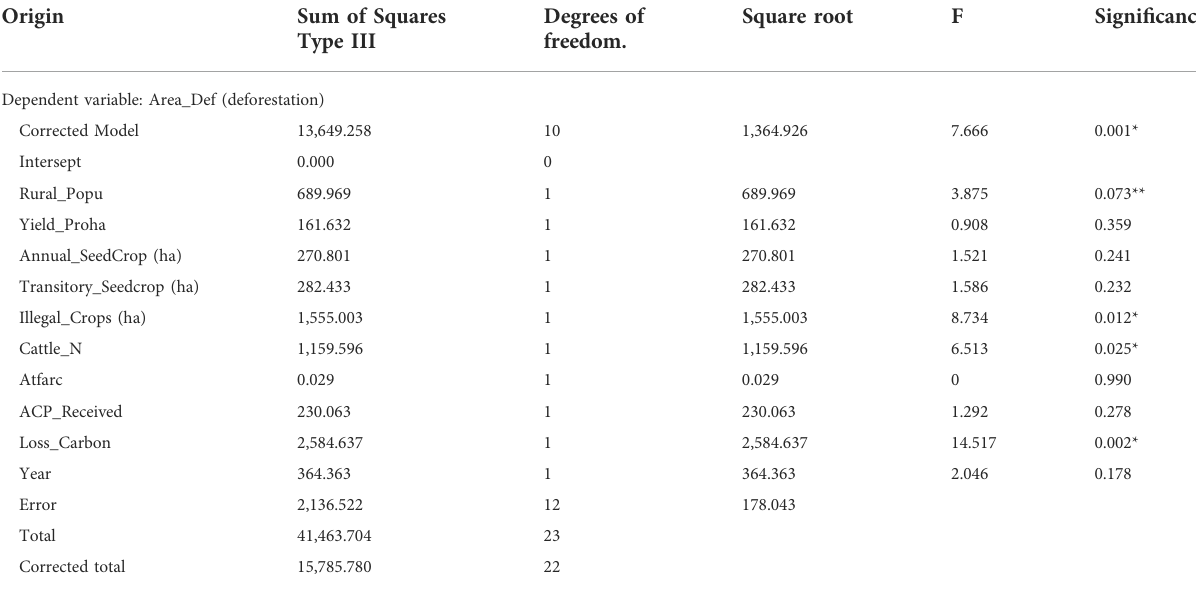
TABLE 6 Tests of inter-subject effects with a factorial model.